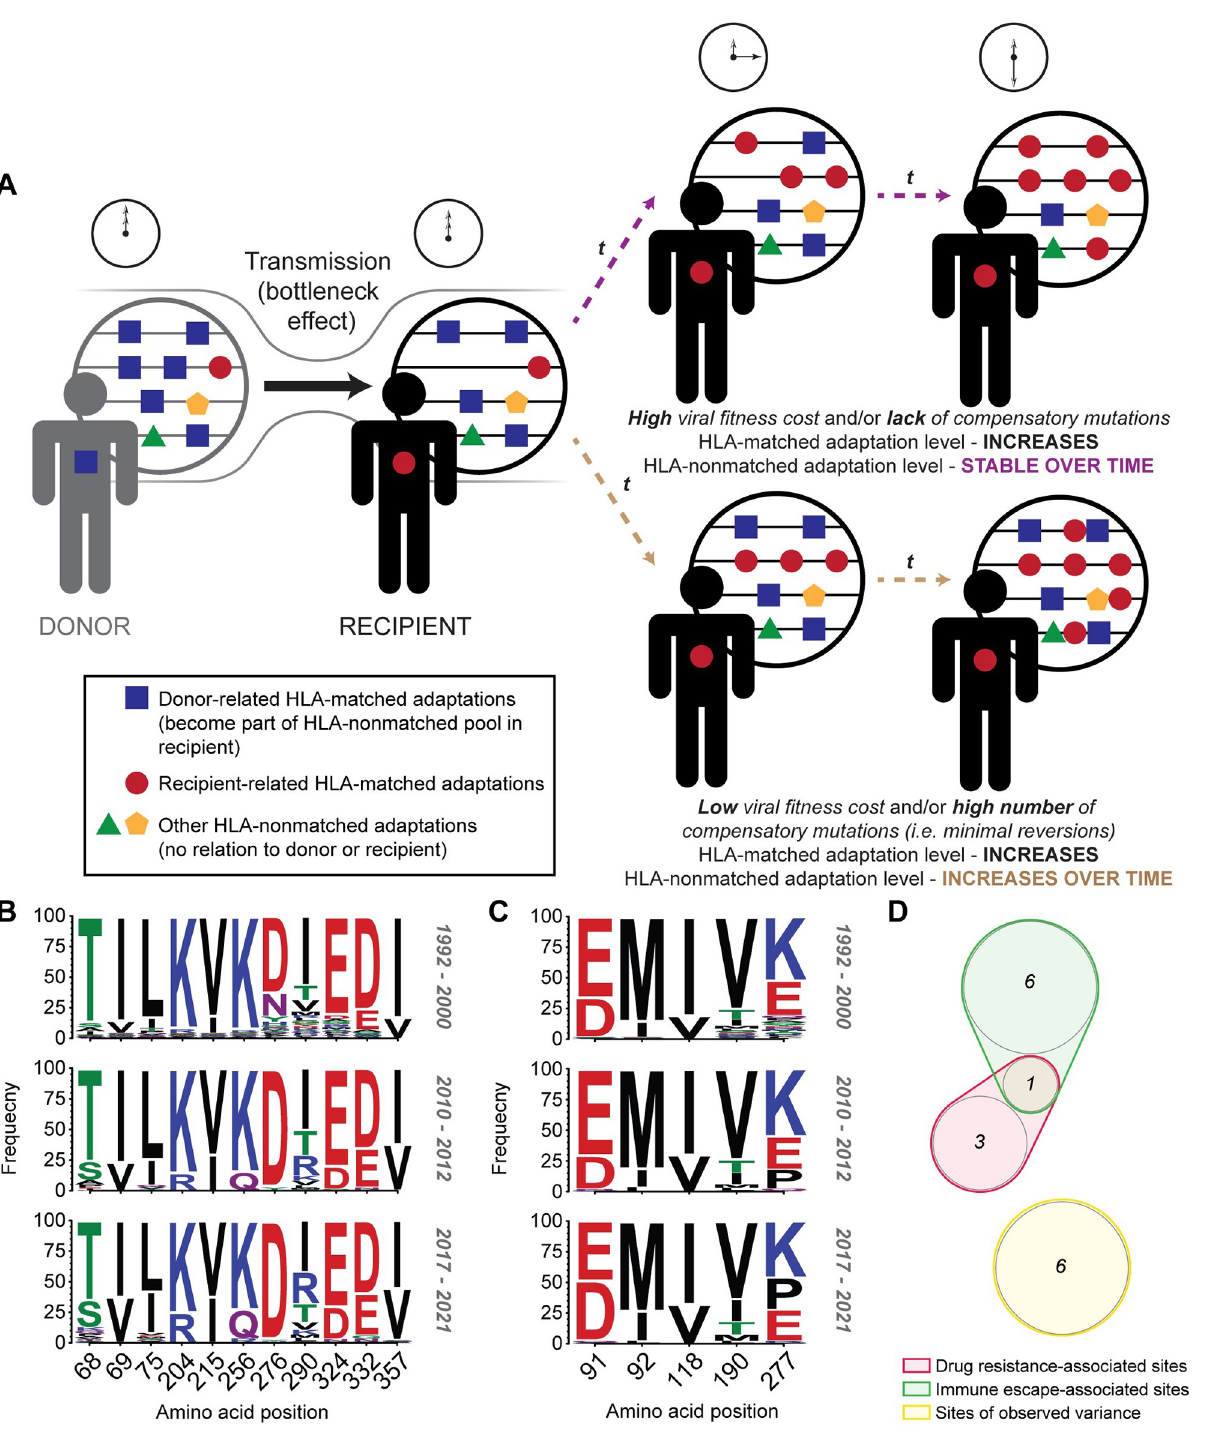
Fig 5. Evidence of accumulation of viral adaptations at a population level. A) Schematic of viral adaptation dynamics following transmission between HLA-mismatched donor-recipient pairs. Viral adaptations can be separated into two types: HLA-matched (adaptations relevant to the host’s HLA alleles; red circle) or HLA-nonmatched (adaptation to all HLA alleles, excluding those of the host; green triangle, yellow pentagon). HLA-matched adaptations have been shown to increase over time within an ART-na ï ve recipient, as a result of HLA-associated CTL immune pressure. Alternatively two potential scenarios related to HLA-nonmatched adaptations have been proposed, one of maintenance (where population-level HLA-nonmatched adaptations are maintained low over time due to high viral fitness costs and/or low numbers of compensatory mutations), or increasing adaptation